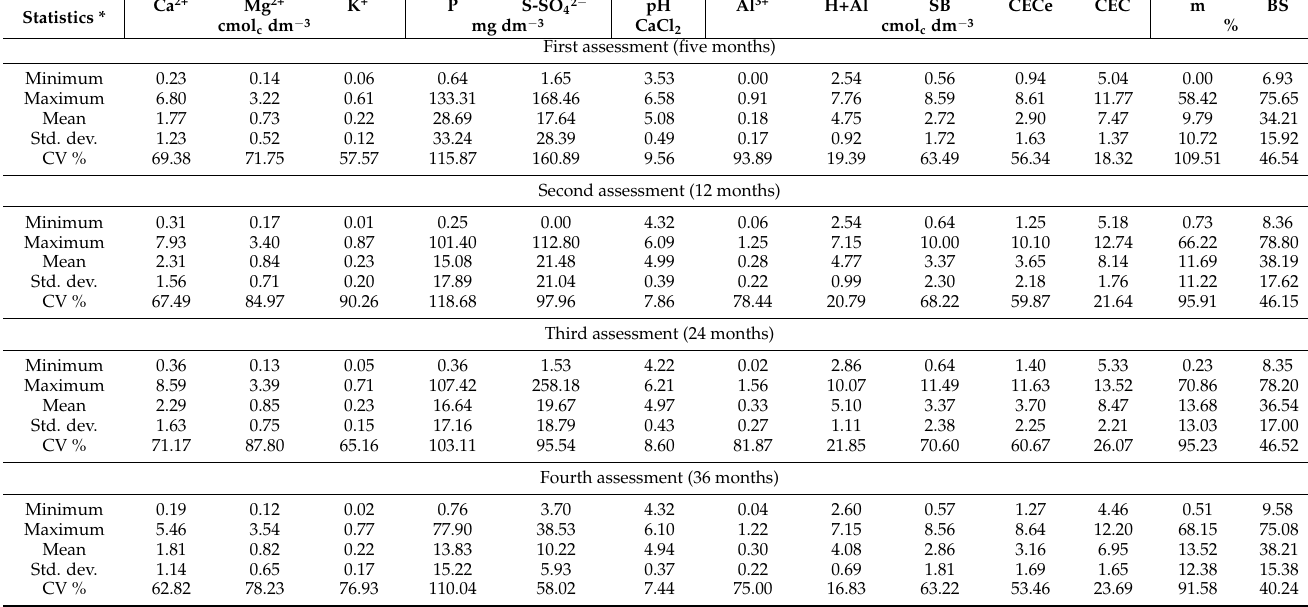
Table 2. Descriptive analysis of the chemical characteristics of the soil over the four soil